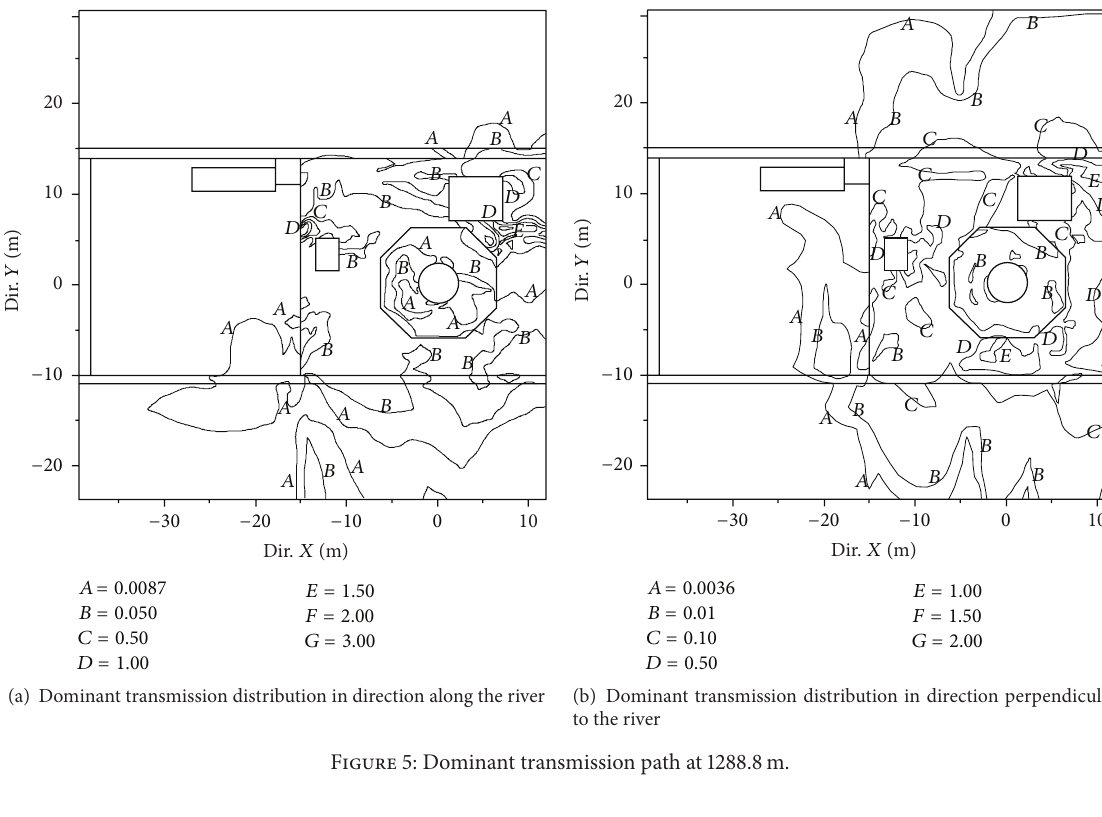
Figure 4: Dominant transmission path at 1269.0 m.